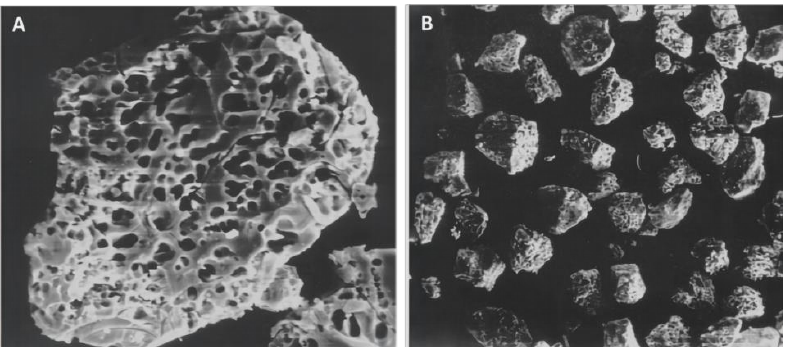
Figure 6. SEM micrographs of porous fillers after HF acid etching were shown at magnifications of ( A ) 2000× and ( B ) 500×. The liquid resin can enter the pores of the porous fillers, and the resulting strength effects are related to this phenomenon. Images from [86].